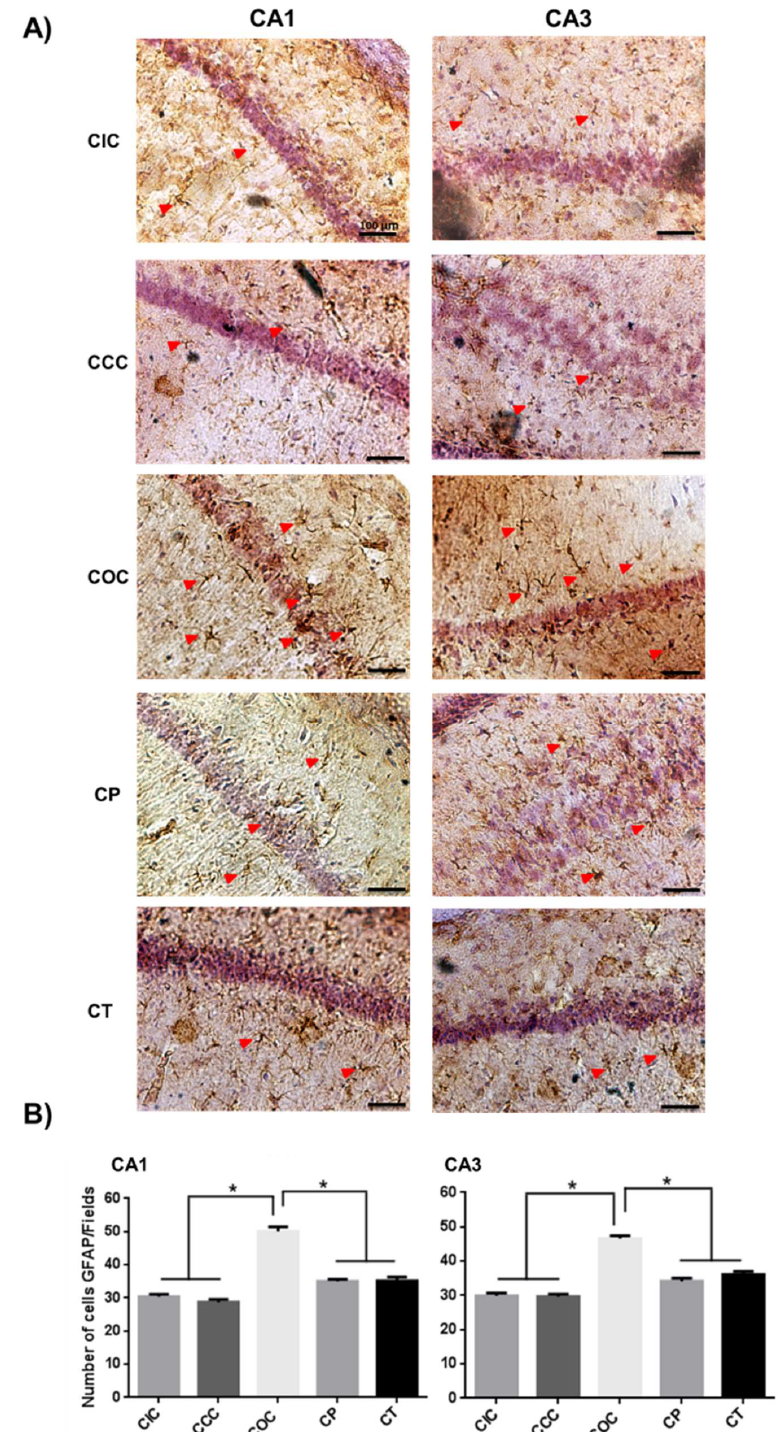
Figure 2. Effect of CUR on the astrocyte activation caused by chronic exposure to O 3 . ( A ) Representative light photomicrographs show GFAP immunoreactivity (red arrowheads) in CA1 and CA3 regions of the rat hippocampus in the chronic phase. The chronic ozone control (COC) group presents a larger number of GFAP immunoreactive cells than the chronic intact control (CIC) group. The chronic preventative (CP) and chronic therapeutic (CT) groups showed a significant decrease in cell immunoreactivity. Scale bars 100 μm. ( B ) Total quantitation of immunoreactive cells are shown in the graph as mean ± SEM. * p < 0.001.